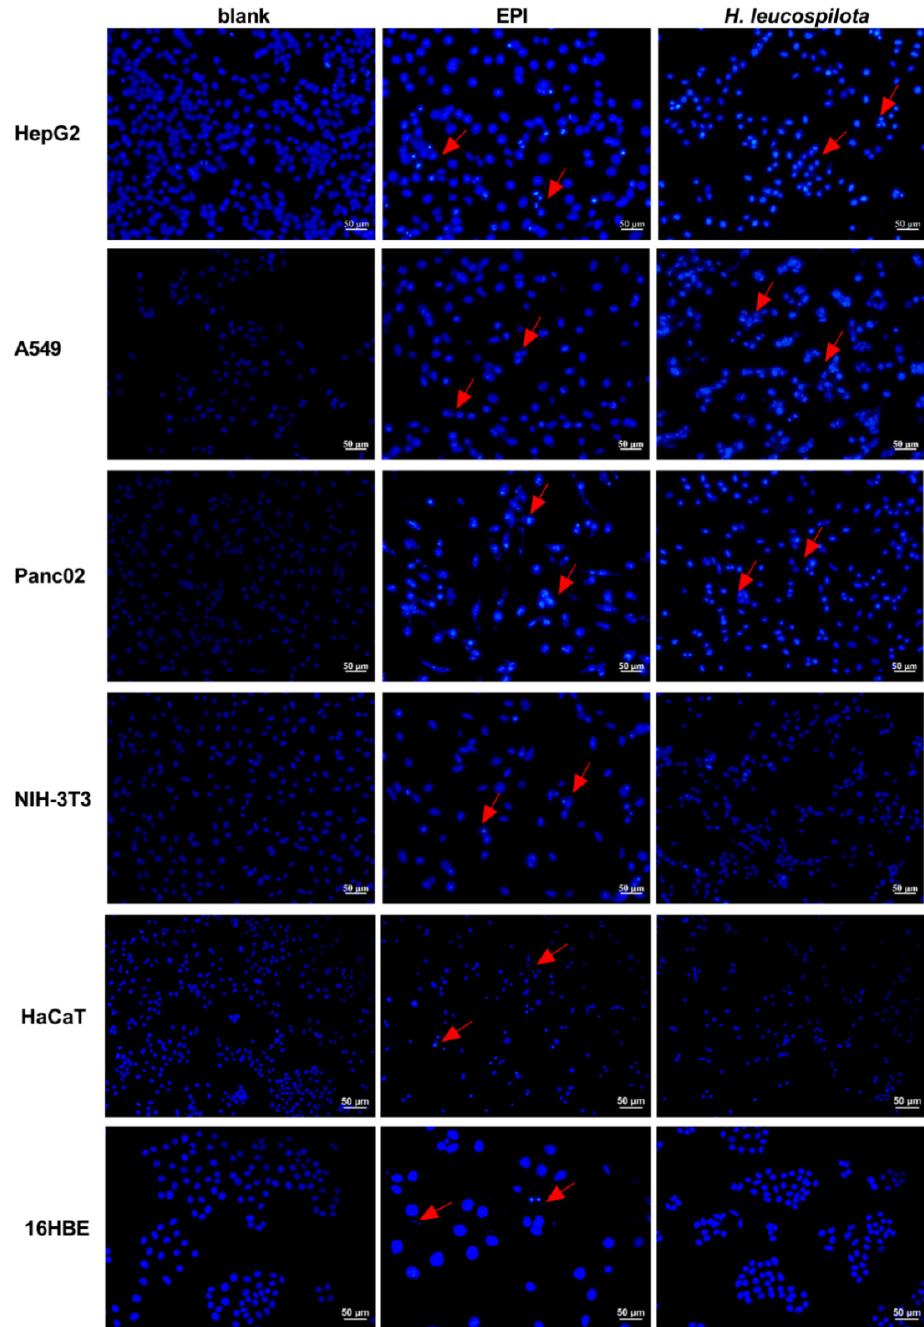
Figure 4. Effect of H. leucospilota protein treatment on cell morphology. Cells were treated with the IC 50 concentrations of H. leucospilota protein for 48 h, and EPI (10 µ M) as positive group. The morphological characteristics of apoptosis were shrunken, hyperchromatic, and pyknotic cells.